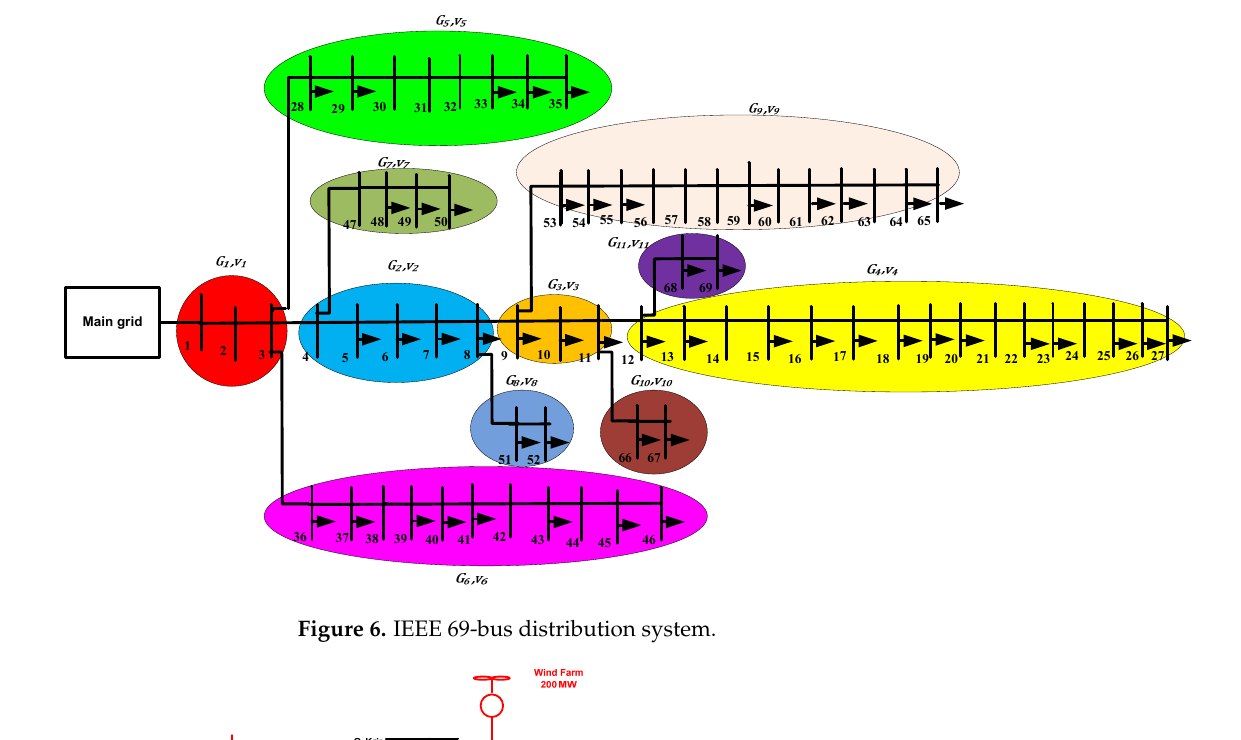
Figure 6. IEEE 69-bus distribution system.